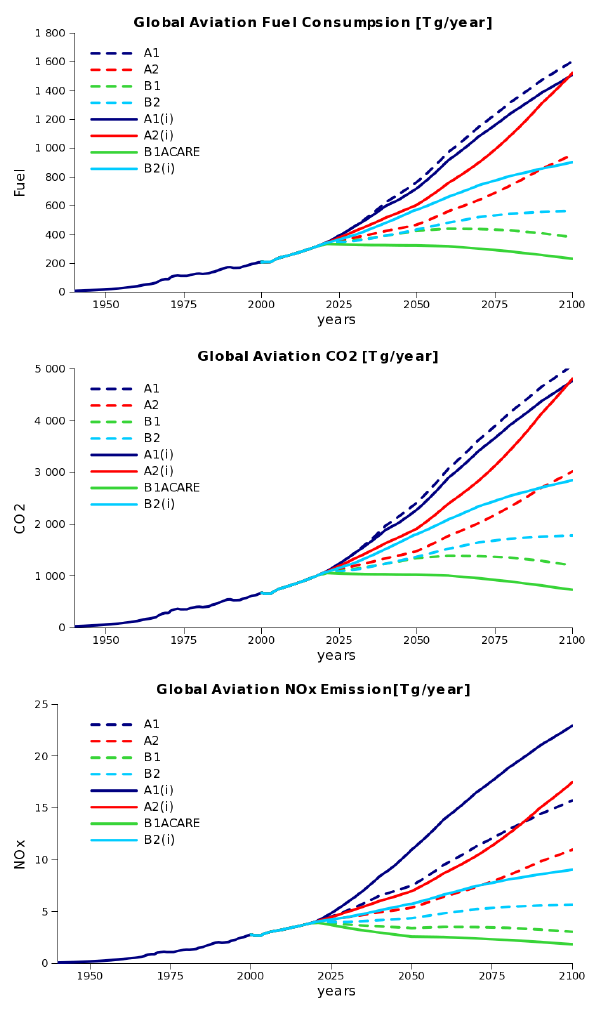
Fig. 2. Global annual fuel consumption: CO 2 and NO x emissions (Tgyr − 1 ) from aviation for the period 1940–2100 for different sce- narios from the QUANTIFY project (Owen et al., 2010). In our sim- ulations, the A1(i) scenario is